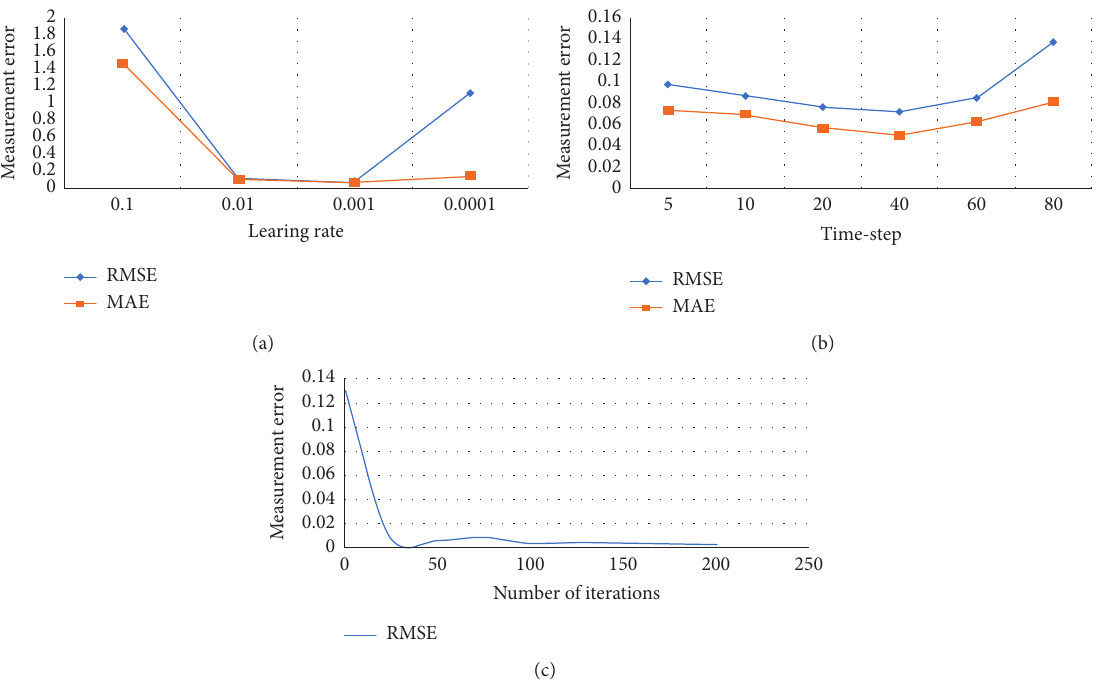
Figure 18: Test error variation chart of each parameter. Test error with (a) learning rate change chart, (b) time-step change chart, and (c) iteration number change chart.